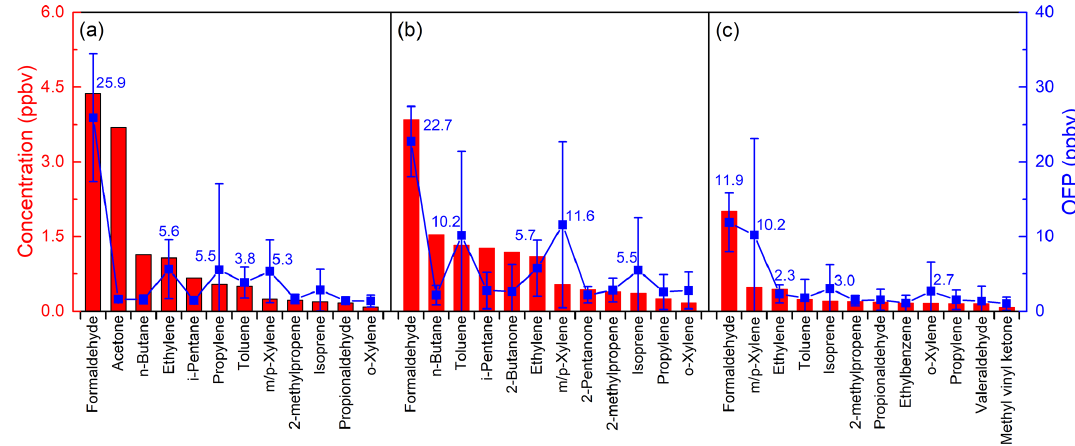
Figure 8. The top 12 NMVOCs in ozone potential formation and their average mixing ratios during (a) Case 1, (b) Case 2 and (c) Case 3 at an urban site of